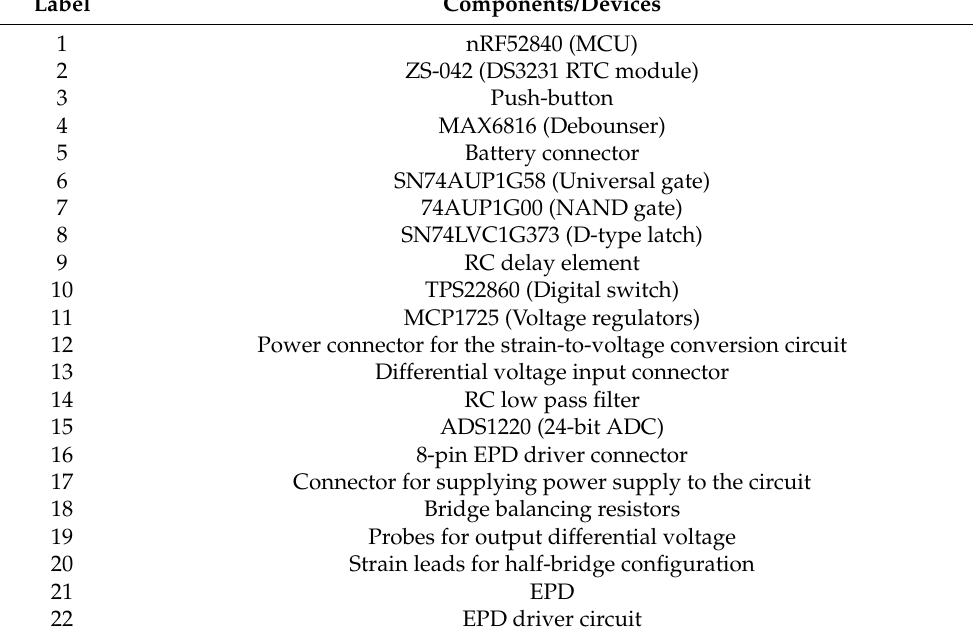
Table 2. Components/device